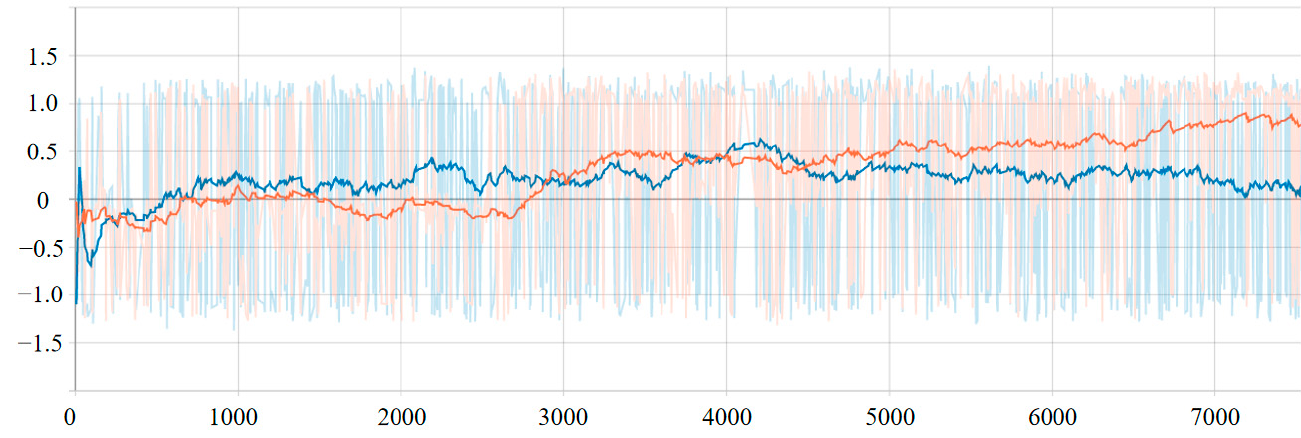
Figure 5. Reward curves during the training process; the orange curve is the training curve of Policy_1, and the blue curve is the training curve of Policy_2.